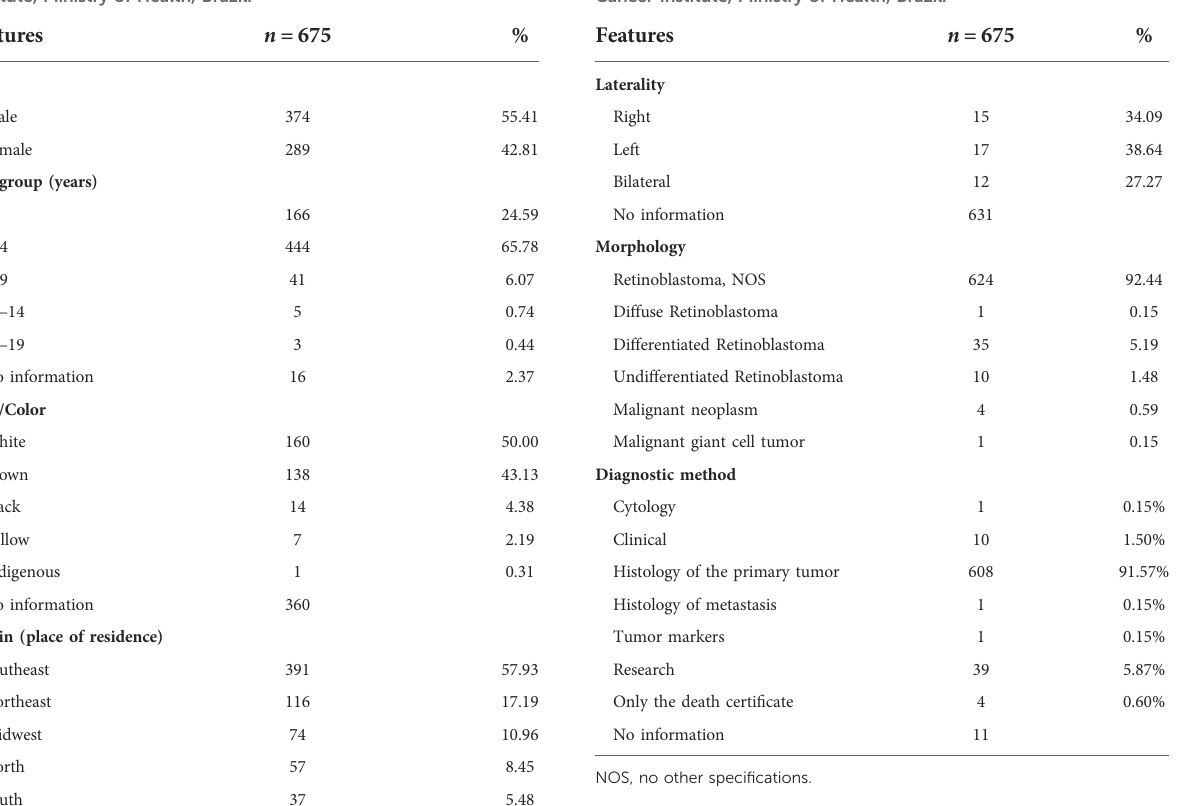
TABLE 2 Clinical characteristics of analytical cases of retinoblastoma from the Population-Based Cancer Registry, 2000 – 2018, National Cancer Institute, Ministry of Health, Brazil.